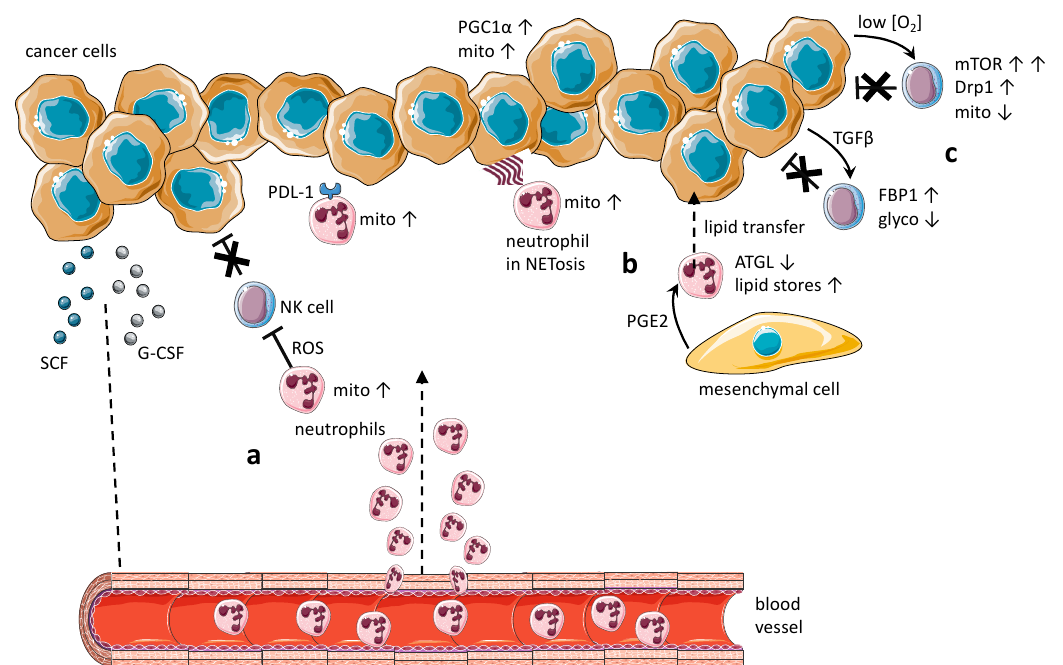
Figure 1. Metabolic profile in pro-tumor immune cells with a focus on neutrophils and NK cells. ( a ) Cancer cells secrete growth factors and cytokines, such as SCF and G-CSF [71,72], that recruit immature, pro-tumor neutrophils in the TME. These neutrophils rely mostly on a mitochondrial metabolism and are immunosuppressive for T and potentially for NK cells [71], promote cancer metastasis through NETosis [72] and express increased levels of PD-L1, contributing to the immunosuppressive milieu in the TME [73]. ( b ) Pro-tumor neutrophils may support metabolic competence in cancer cells. Two examples: neutrophil elastase released from NETs activates TLR4 signaling in cancer cells, leading to upregulation of PGC1a, the master regulator of mitochondria biogenesis [74]; upon interaction with resident mesenchymal cells, pro-tumor neutrophils are induced to accumulate lipids due to inhibition of the ATGL enzyme. Thereafter, lipids stored in neutrophils are transported to tumor cells, increasing metabolism in these cells [75]. ( c ) Molecular cues from the TME lead to metabolic and functional changes in NK cells. Early glycolytic, cytotoxic, and anti-tumor NK cells become dysfunctional in later phases of tumorigenesis due to the over-expression of FBP-1 and concomitant inhibition of glycolysis. This process is possibly driven by TGF β [76]. Hyperactivation of mTOR signaling in cytotoxic anti-tumor NK cells, due to the persistent stress of the hypoxic TME, leads to activation of Drp1 and impaired mitochondrial metabolism. As a result, NK cells become dysfunctional [77]. The described mechanisms refer to cancers in the mammary gland [71,72], in the lung [76], in the colon [74], in the liver and in the pancreas [73].